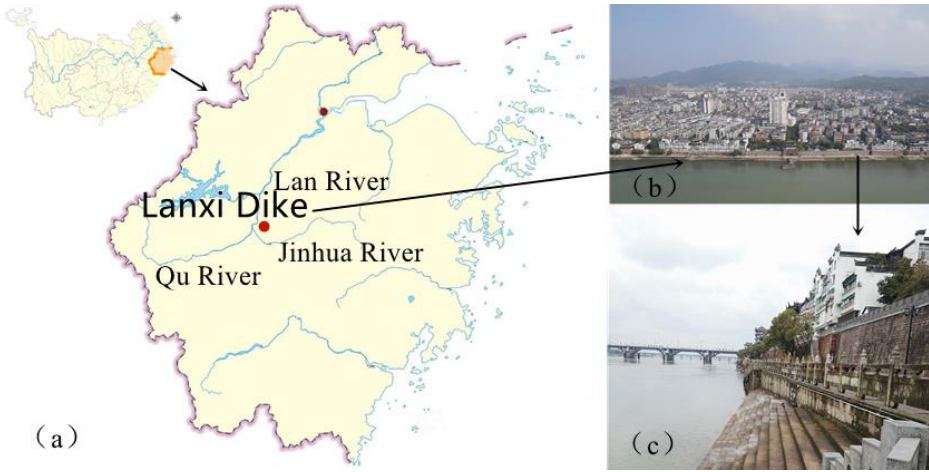
Figure 3. Geographical location and appearance of Lanxi ancient riverbank. ( a ) Geographical location; ( b ) overall view of Lanxi ancient flood bank; ( c ) local appearance of ancient flood bank.